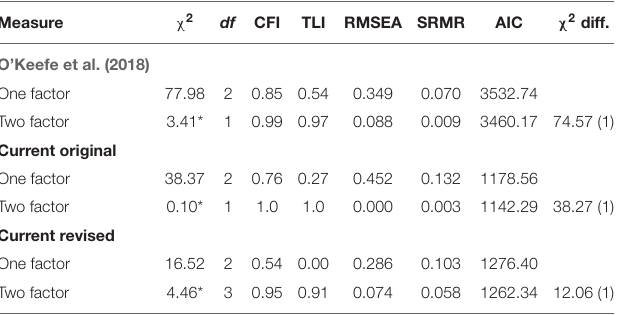
TABLE 5 | Fit indices for alternative factor models of original and revised implicit theories-of-interest development.